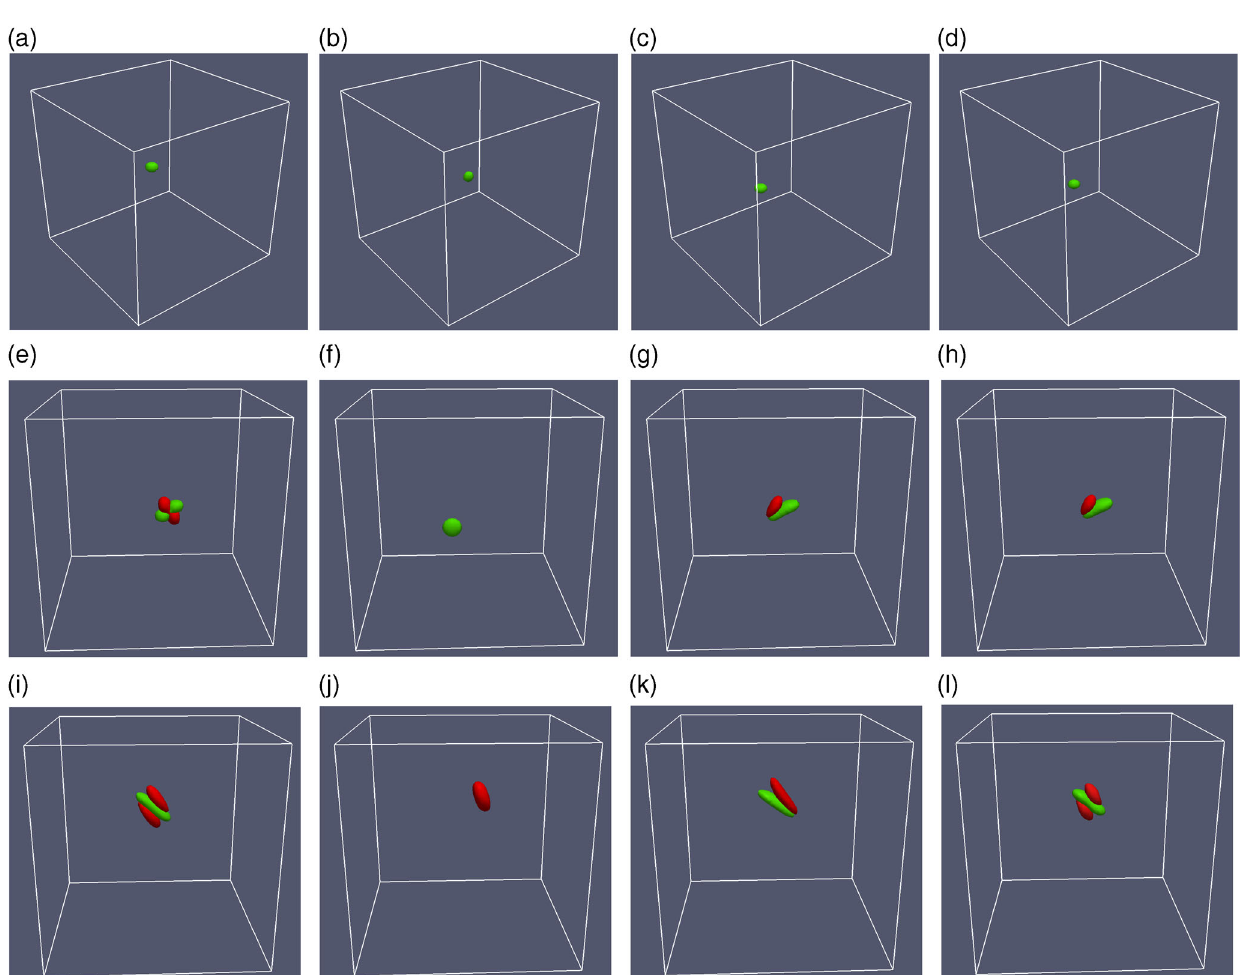
larger energy) to overcome the much higher strain energy penalty compared with cases of ξ = 0.5 and ξ = 0.8. For the case of LP, a critical nucleus of internally twinned two-variant con fi guration is obtained, same as in ref. 30. For NP1, the critical nucleus is still single-variant, while for NP2, the critical nucleus con fi guration is